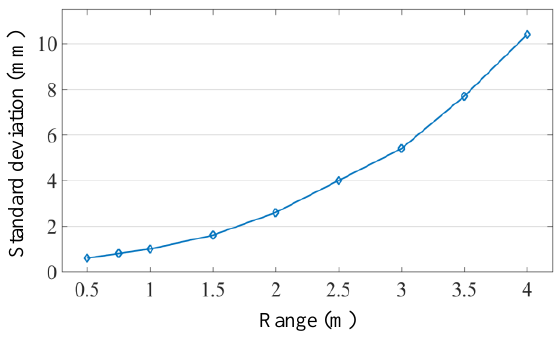
Figure 4. Influence of the range on the point cloud precision The standard deviation increases with the range. This means that the range has a negative influence on the precision of the captured data. However, point clouds acquired at very close ranges (0.5 m and 0.75 m) needed to be rescanned several times, since they suffered from superimposed layers of points that locally provide a “double skin” effect to the point